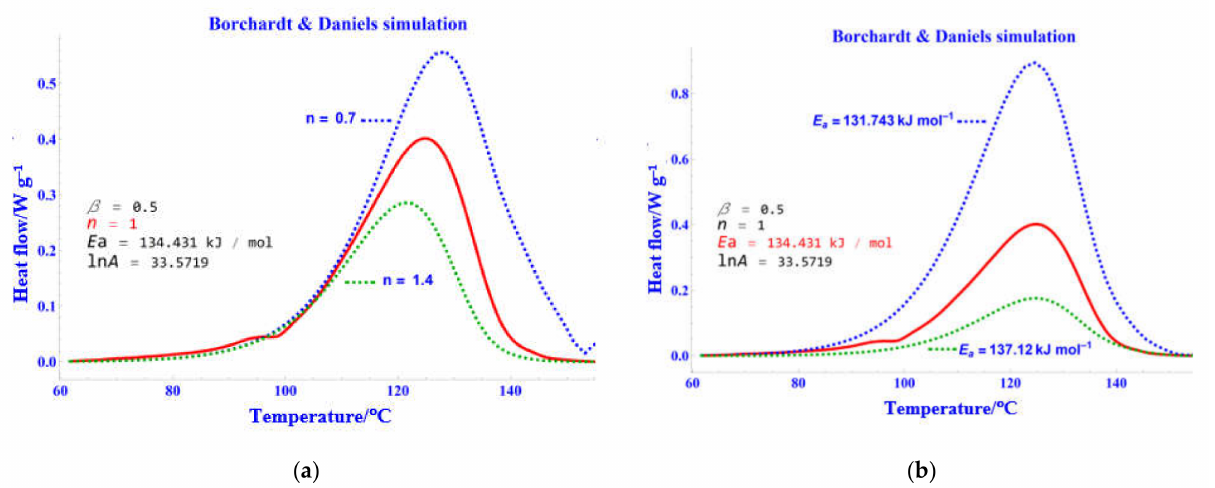
Figure 18. Effects of varying nth kinetic parameter ( a ) variation on reaction order; ( b ) variation on apparent activation